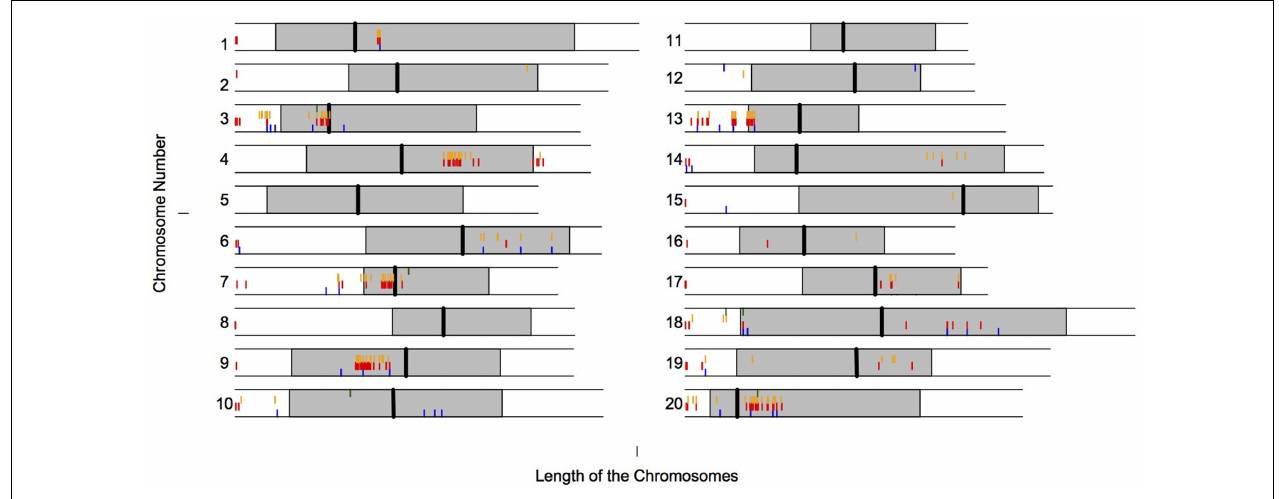
FIGURE 4 | Physical location of LHGRs across chromosomes. The shaded area represents the pericentromeric region (SoyBase).The vertical line represents the predicted centromeric region (SoyBase). Blue bar, Family A; Red bar, Family B; Orange bar, Family C; Green bar, Family